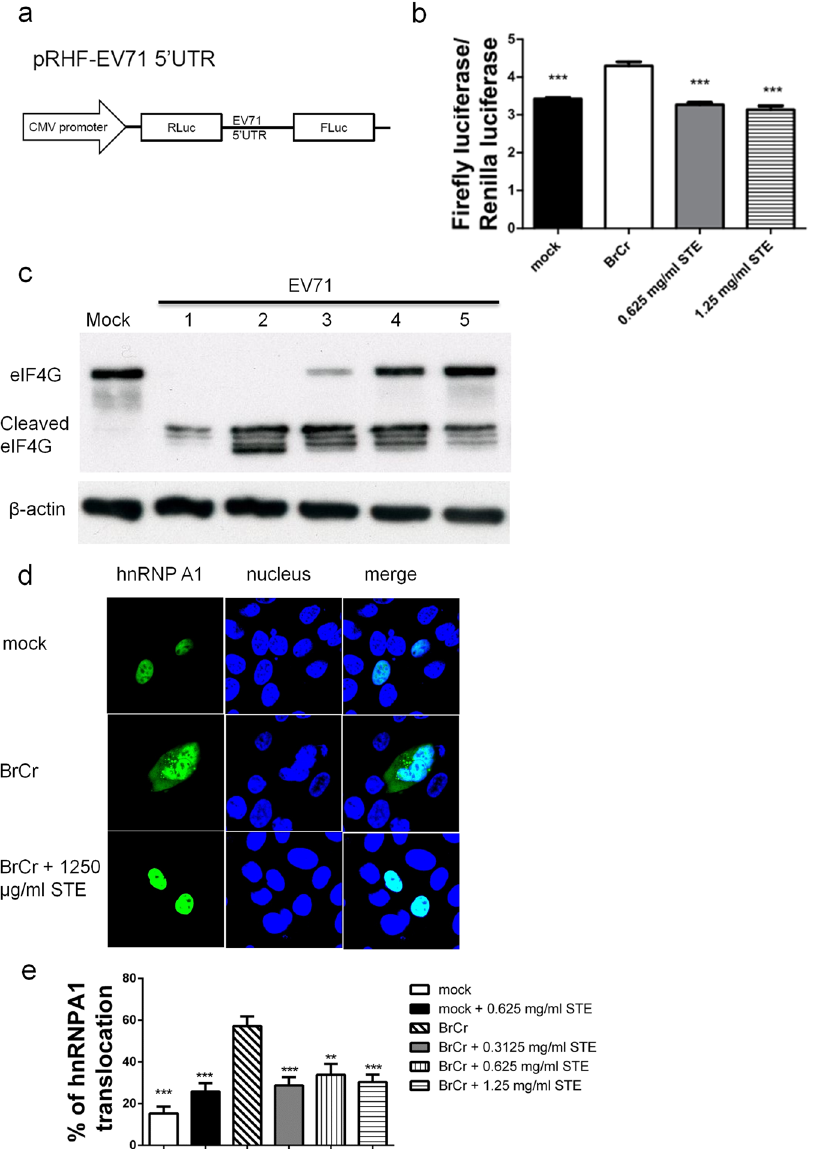
Figure 3. STE blocks EV71-induced shutoff of cap-dependent translation and initiation of IRES-dependent translation in host cells. ( a ) The bicistronic plasmid pRHF-EV71-5 ′ UTR for analysis of cap-dependent and IRES-dependent translation is depicted. ( b ) RD cells were transfected with pRHF-EV71-5 ′ UTR. Twelve hour later, the transfected cells were mock- or infected with BrCr at m. o. i. of 20 for 1 h, and treated with 625 or 1250 µ g/ml STE for 6 h. The activities of firefly luciferase and renilla luciferase were measured. Data are means ± SD of three separate experiments. *** P < 0.0001, vs. infected cells without treatment. ( c ) RD cells were infected under conditions described in the legend of Fig. 2a. The number shown above the western blot image indicates the condition of treatment. Cells were harvested for western blotting with antibodies to eIF4G and β -actin. The positions of intact and cleaved eIF4G are indicated. The cropped images of the blots are shown. A representative experiment out of three is shown. ( d ) RD cells were transfected with expression vector encoding GFP-tagged hnRNP A1. Forty-eight hour later, the transfected cells were infected with EV71 at m. o. i. of 20 for 1 h, and subsequently treated with 1250 µ g/ml STE for 6 h. The cells were fixed and stained with Hoechst 33342 for confocal microscopy. A representative experiment out of three is shown. ( e ) Cells were transfected, infected, and treated with indicated concentrations of STE as described in ( d ). The cells were fixed, stained with Hoechst 33342, and subject to image analysis using IN Cell Analyzer 1000. The percentage of cells showing cytoplasmic relocation of hnRNP A1 were quantified. Data are means ± SD of three separate experiments. ** P < 0.005; *** P < 0.0001; vs. infected cells without